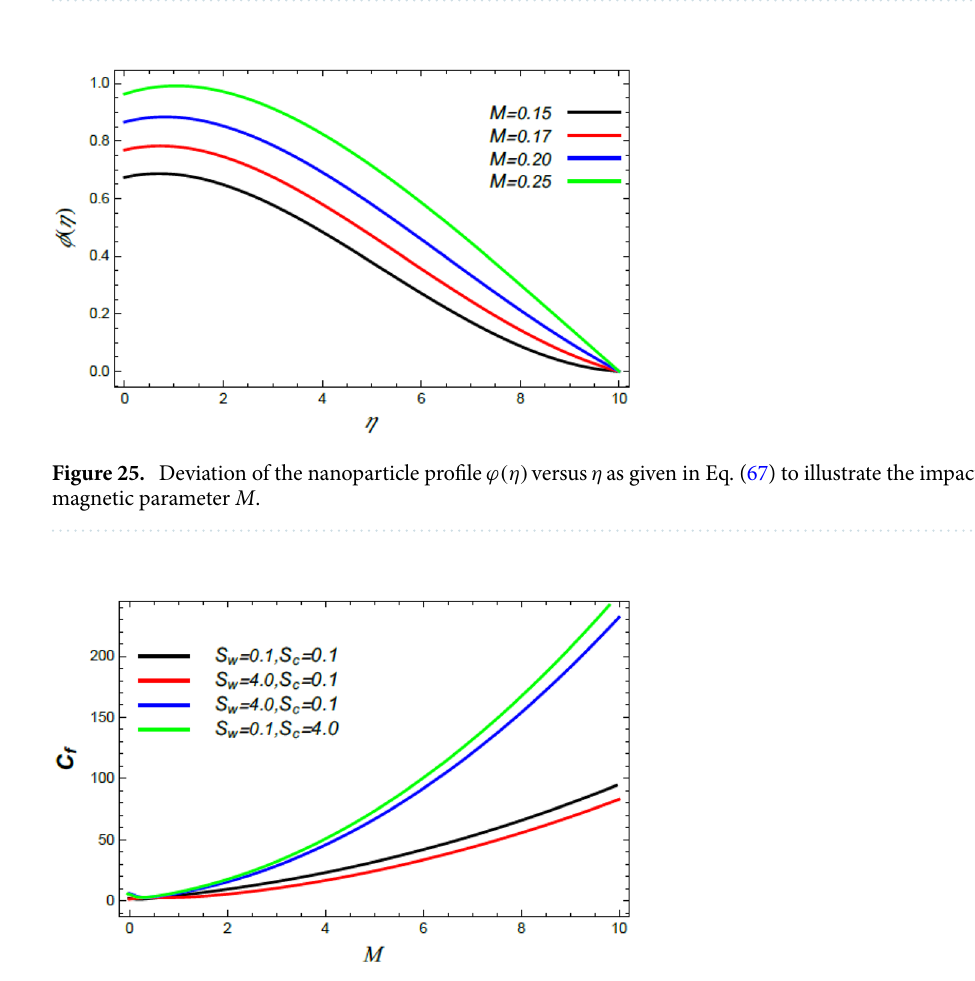
Figure 24. Deviation of the nanoparticle profile ϕ(η) versus η as given in Eq. (67) to illustrate the impact of the Stefan blowing factor S w .